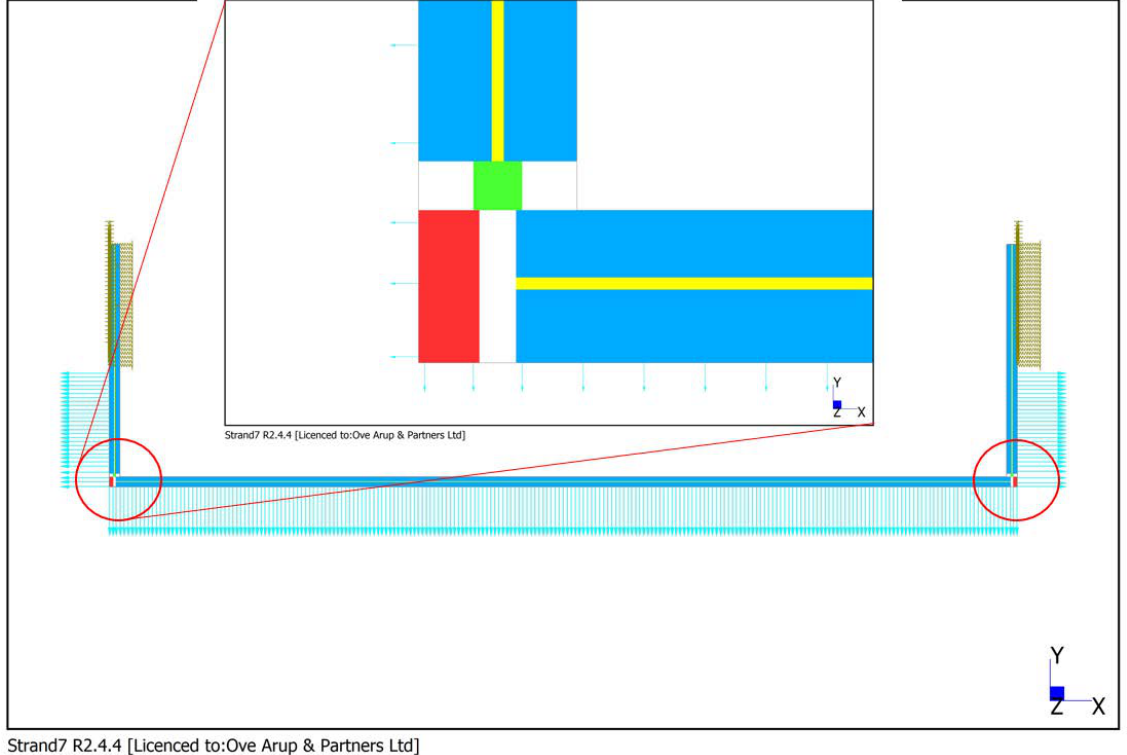
Fig. 9 Numerical model of section of façade with the joint